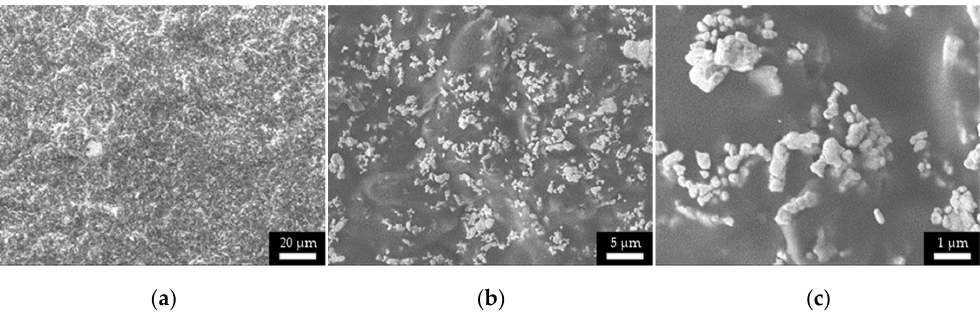
Figure 5. SEM micrographs at different magnification (500x ( a ) –3000x ( b ) –12000x ( c )) of the sintered ink surface before injection molding. Micrographs were taken with an E beam power of 5 kV. Micromachines 2019 , 10 , x